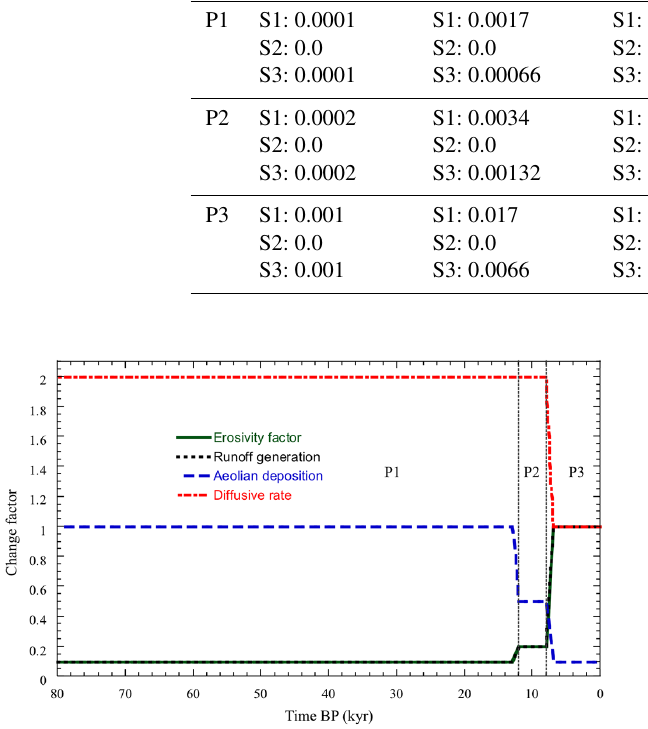
Figure 3. The simulation scenario. Describes the temporal changes in four model parameters as a function of climatic and anthro- pogenic drivers. The erosivity factor is overlapping with the runoff generation